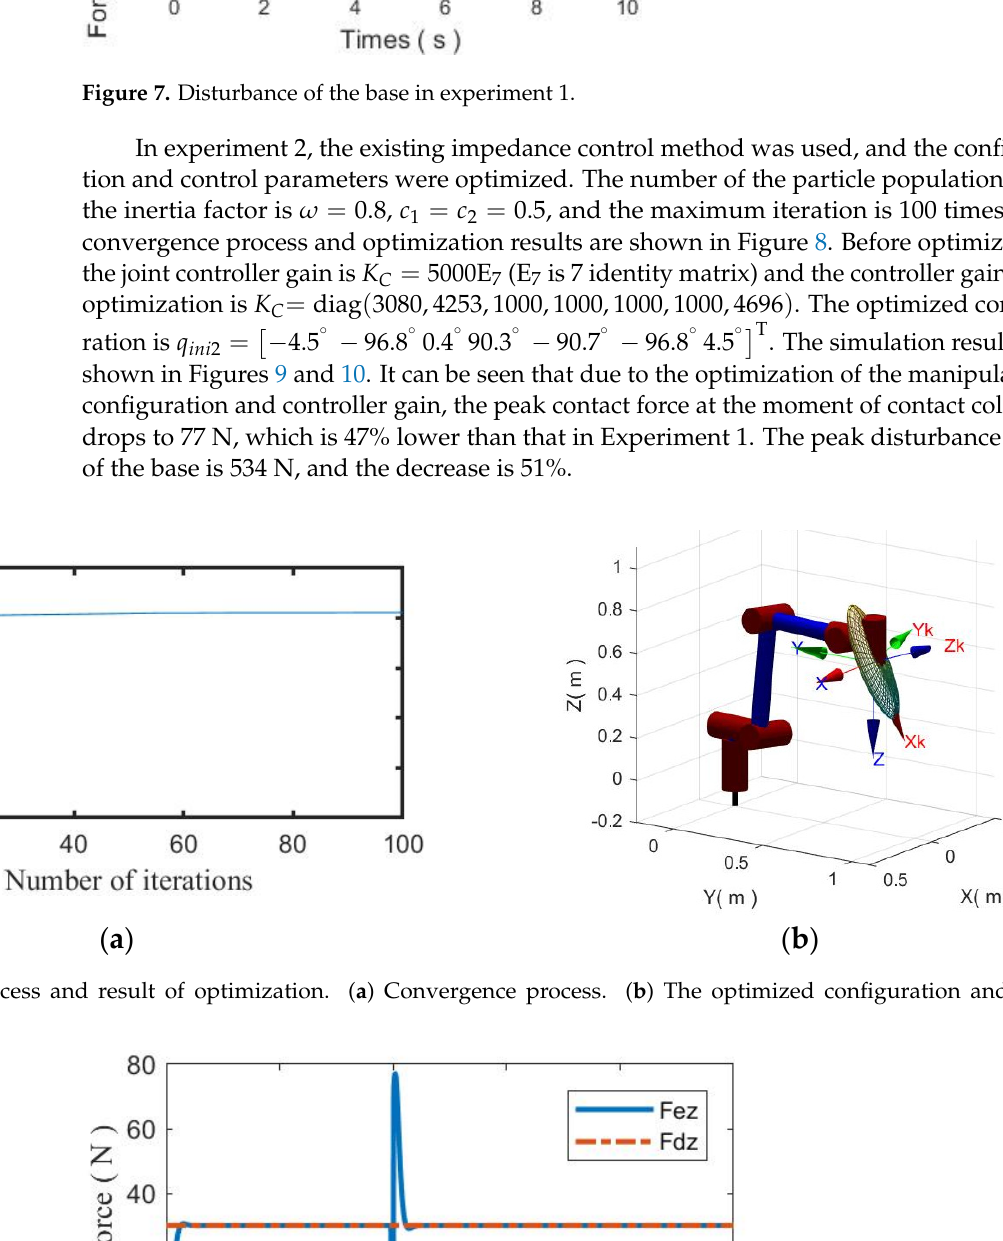
Figure 7. Disturbance of the base in experiment 1.